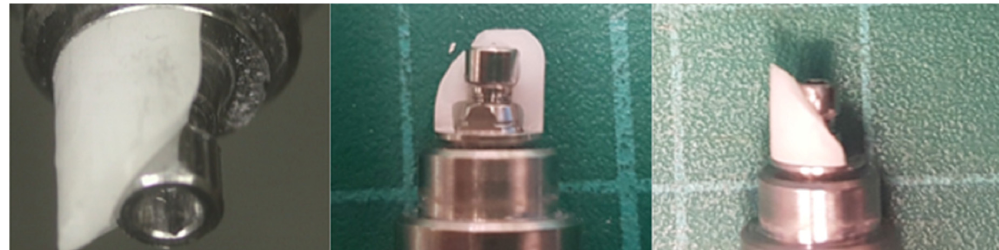
Figure 3. Specimen number one in group A shows fracturing of the zirconia concomitantly with bending of the restoration screw head under an applied load of 450 N. This failure was observed in group A at only high loading forces.